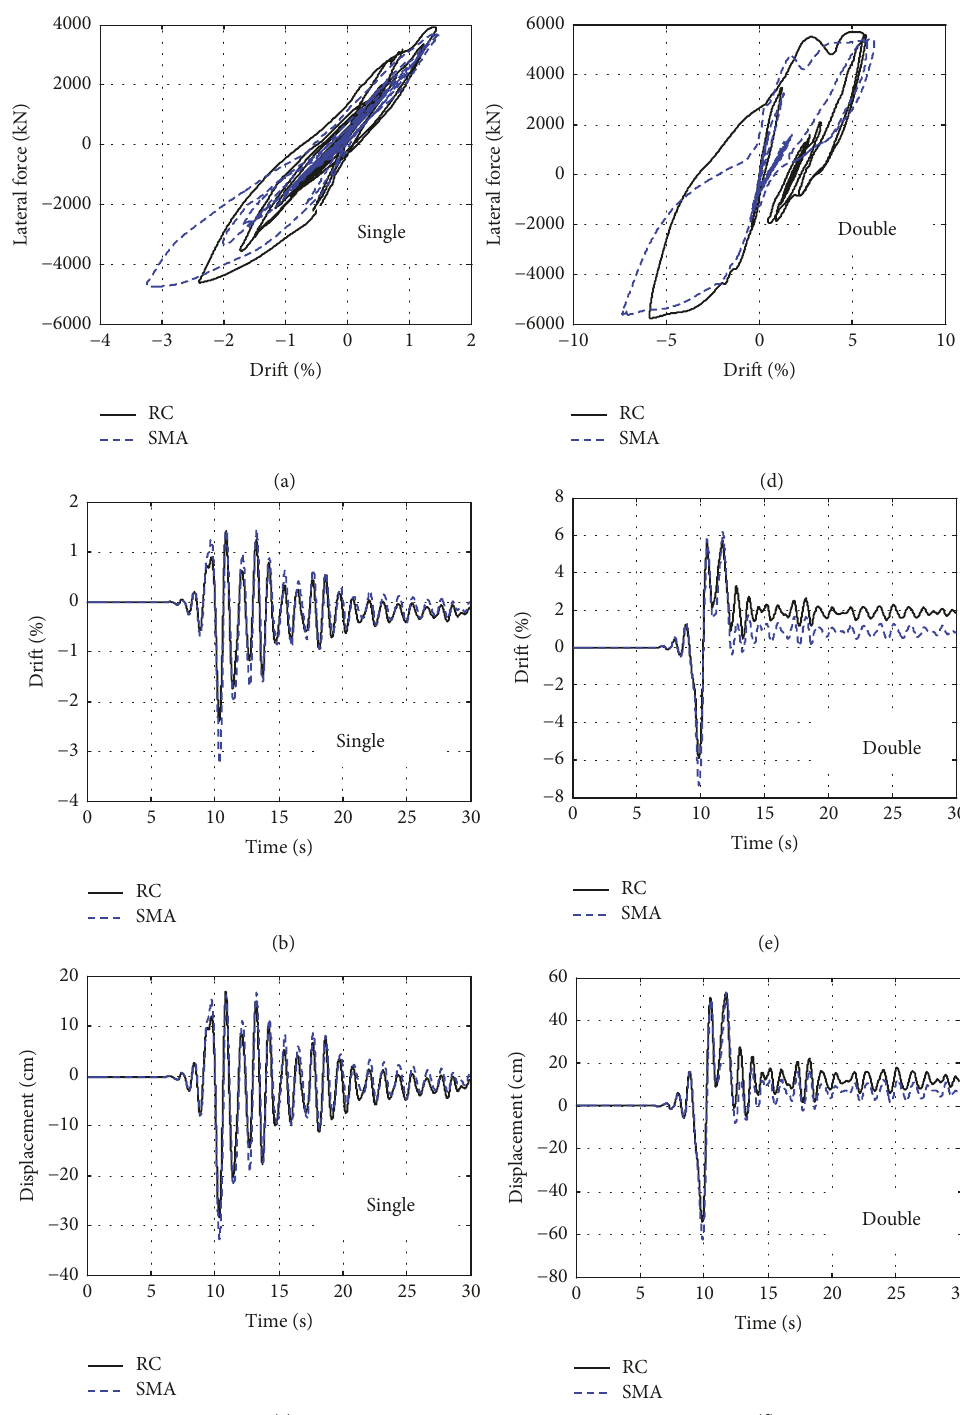
Figure 10: The response of the Pier 3 under longitudinal acceleration excitation: (a) and (d) base shear versus drift hysteresis curves, (b) and (e) relative drift of piers, and (c) and (f) top displacement history of